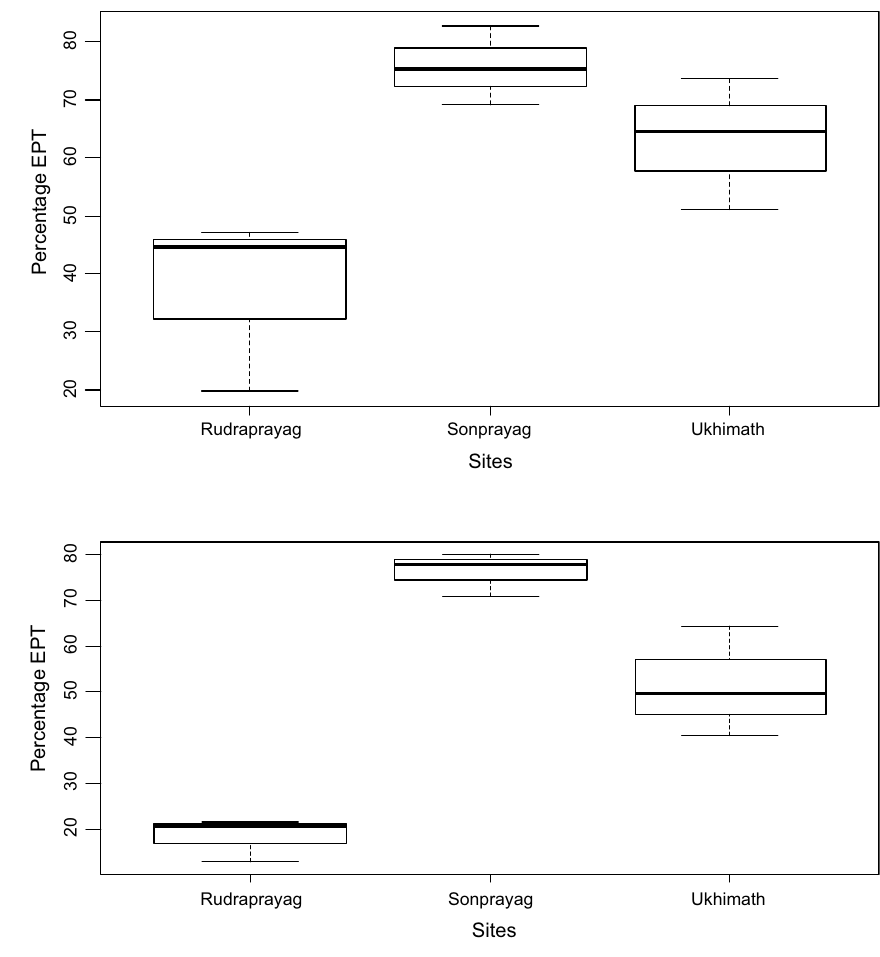
Fig. 2 Variation in %EPT dur- ing pre-monsoon season (May, 2017)